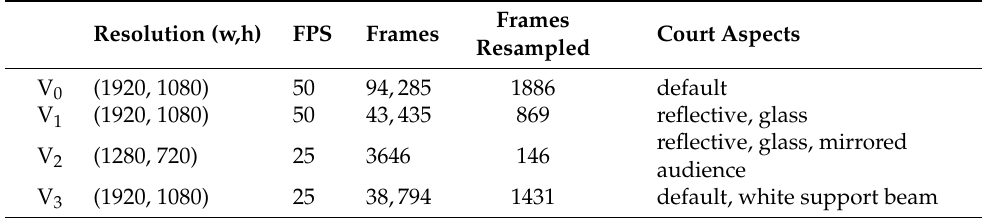
Table 4. Additional information for videos included in the